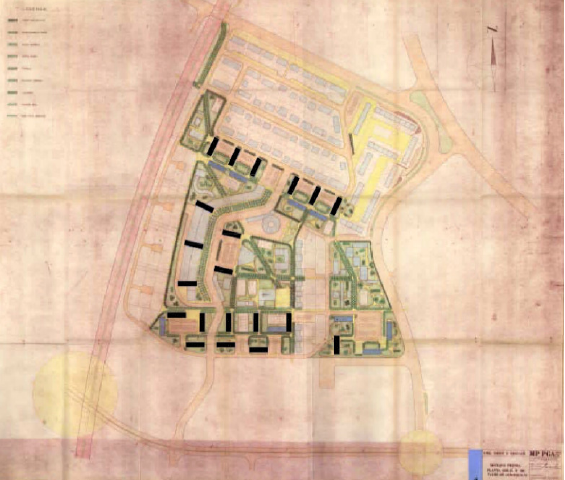
Figure 3. Neighbourhood Unit No. 1, Luanda (drawing). Source: Carvalho